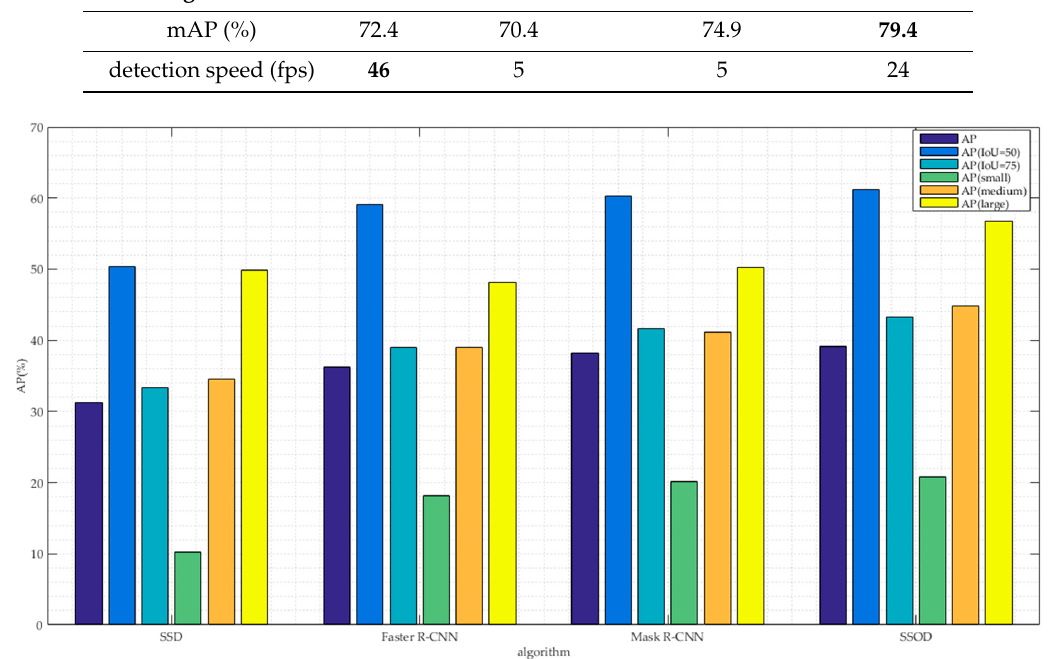
Figure 4. Comparison of our method and other state-of-the-art methods in terms of AP values (%) on the MS COCO dataset.